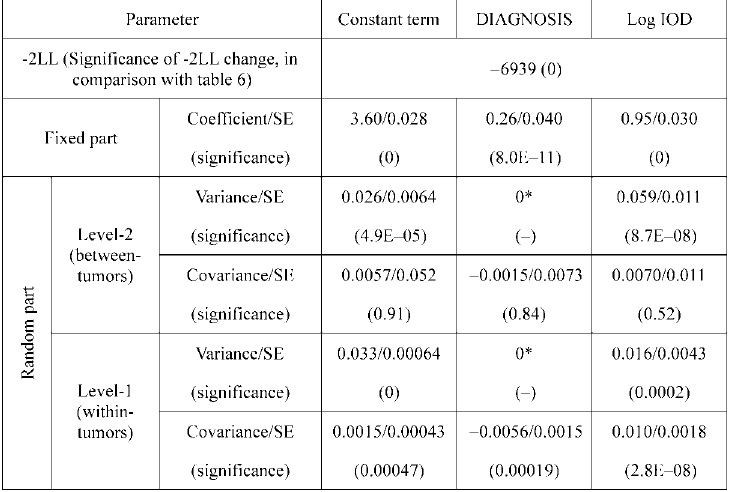
Notes: − 2LL – negative doubled log likelihood. SE – standard error. Parameters marked by asterisk * were pre-constrained to 0, because they were redundant [29]. Significance levels lower than 1.0E10-99 are presented as